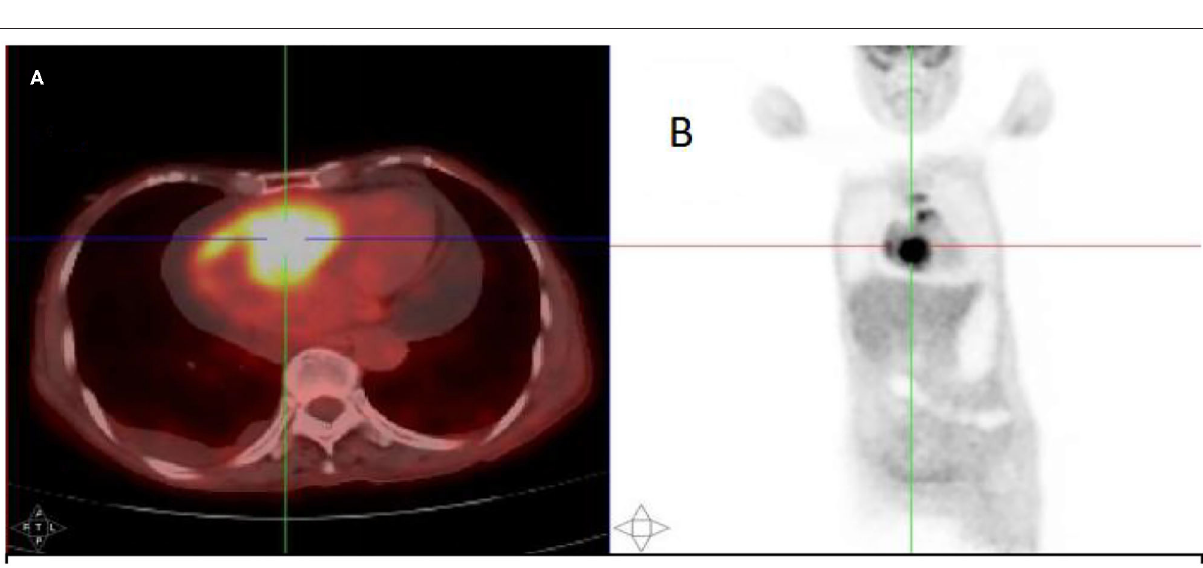
FIGURE 4 | The 18F-fluorodeoxyglucose positron emission tomography (PET)/CT scan. (A) A mass in the right atrium with high radiotracer uptake. (B) Whole-body maximum-intensity projection PET images showed high radiotracer uptake in both the right atrium and aorta-ascending